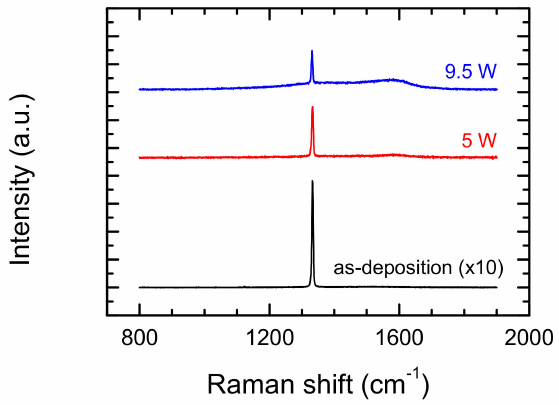
Figure 7. E ff ect of laser power on Raman spectra from modified surface of polycrystalline diamond. Scan speed during the laser etching process was 100 mm / s, hatching distance—5 µ